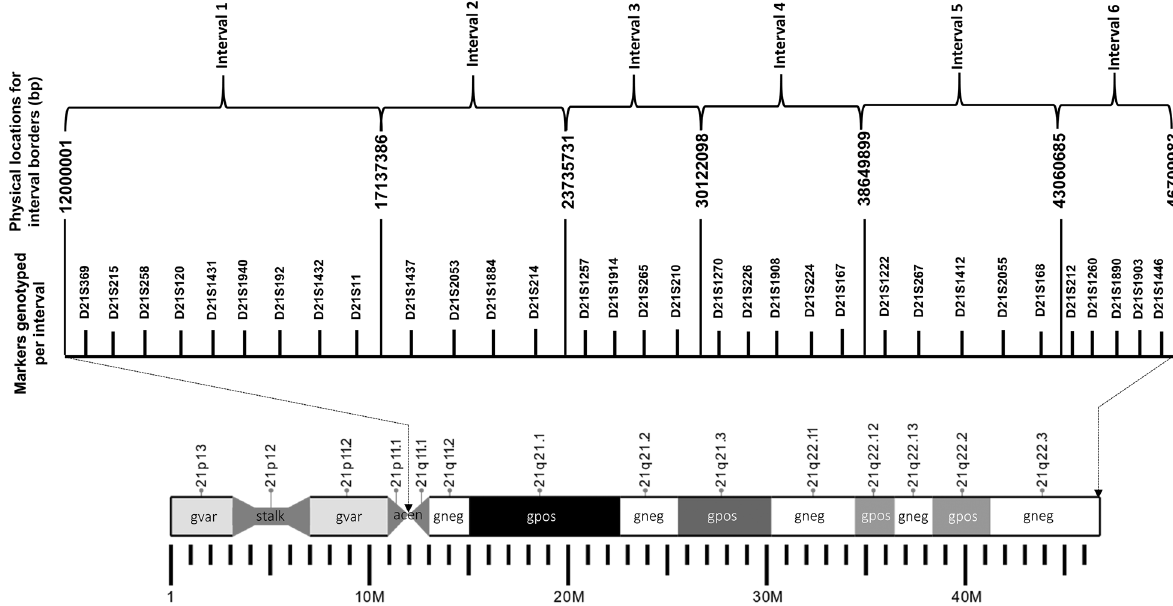
Figure 1. Universal STR markers used to define the origin of the meiotic error and determine the recombination profile. Panel of 32 universal STR markers were used to determine the parental origin (Maternal or Paternal) of error as well as type of meiotic error (Meiosis I or Meiosis II). Only cases in which the error was maternal in origin were included in this study. Once the origin of the error was defined, this genotyping being located in one of six defined